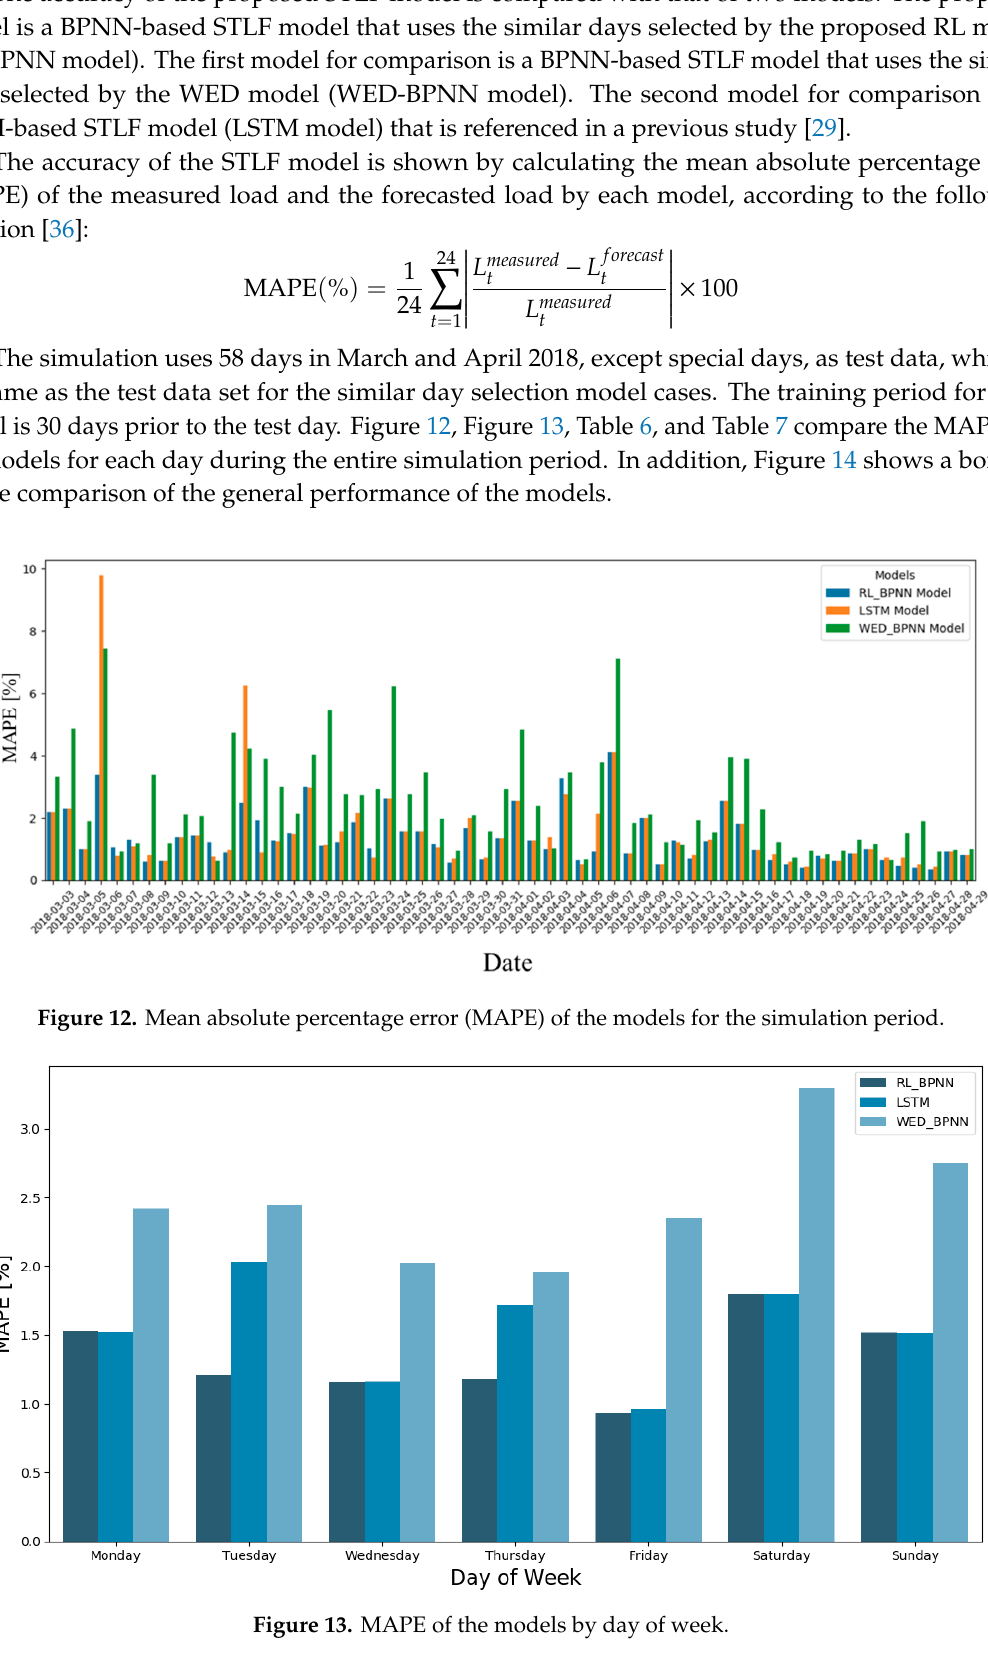
Figure 14. MAPE of the models by day of week. Table 6. MAPE of the models during March and April 2018.